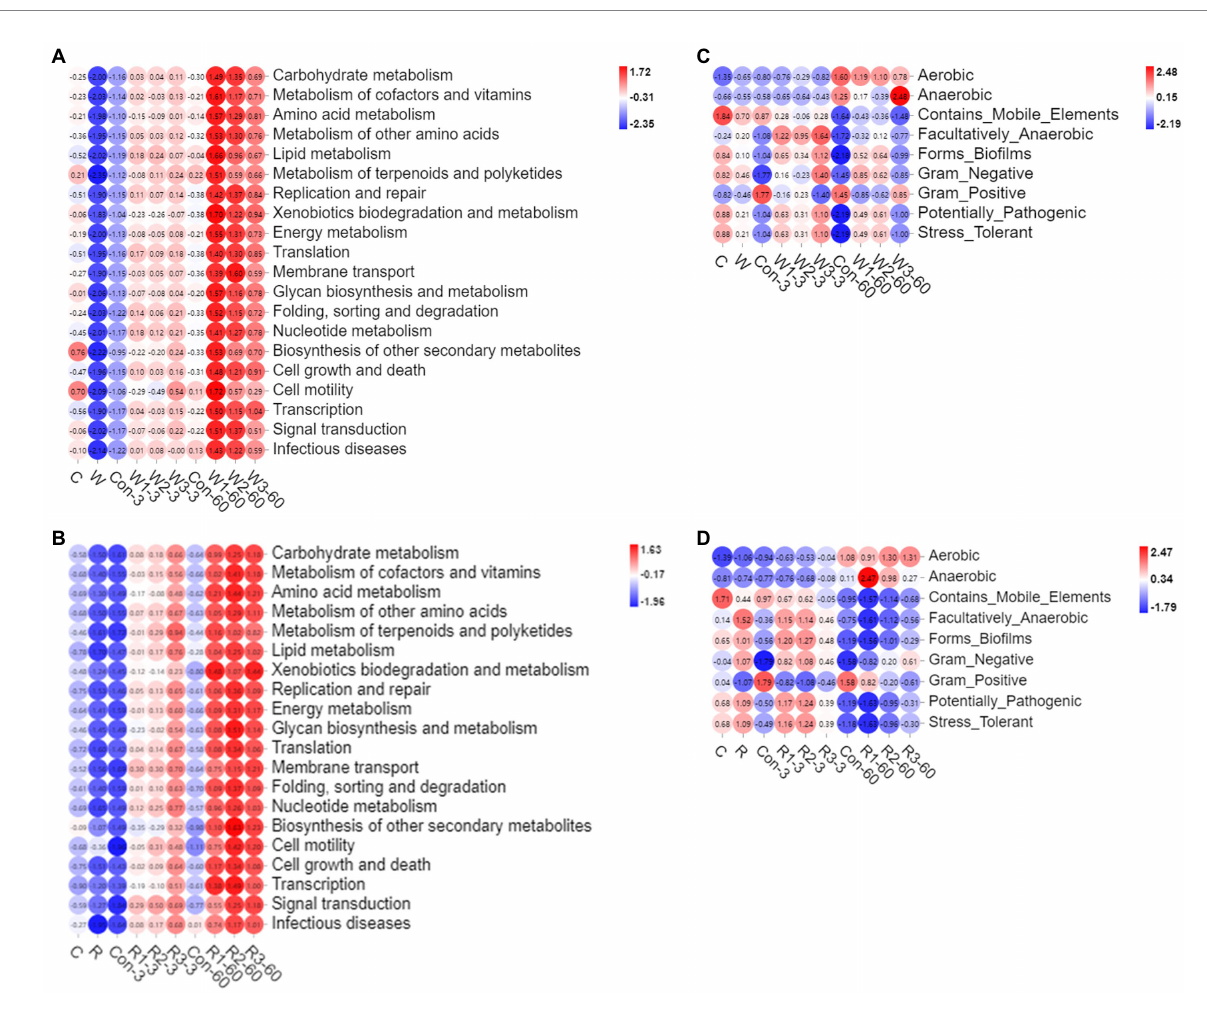
FIGURE 8 16 rRNA-predicted functional profiles were obtained with PICRUSt2 in Chinese cabbage waste anaerobically fermented with wheat bran (A) or rice bran (B) . The bacterial community phenotypes were obtained with BugBase in Chinese cabbage waste anaerobically fermented with wheat bran (C) or rice bran (D) . The control group (Con). Chinese cabbage waste was mixed with wheat bran at a mass ratio of 383:117 (W1), 353:147 (W2), and 323:177 (W3) or with rice bran at 387:113 (R1), 358:142 (R2), and 329:171 (R3), respectively; 3 and 60 mean day 3 and day 60, respectively; raw Chinese cabbage waste (C), raw rice bran (R), raw wheat bran